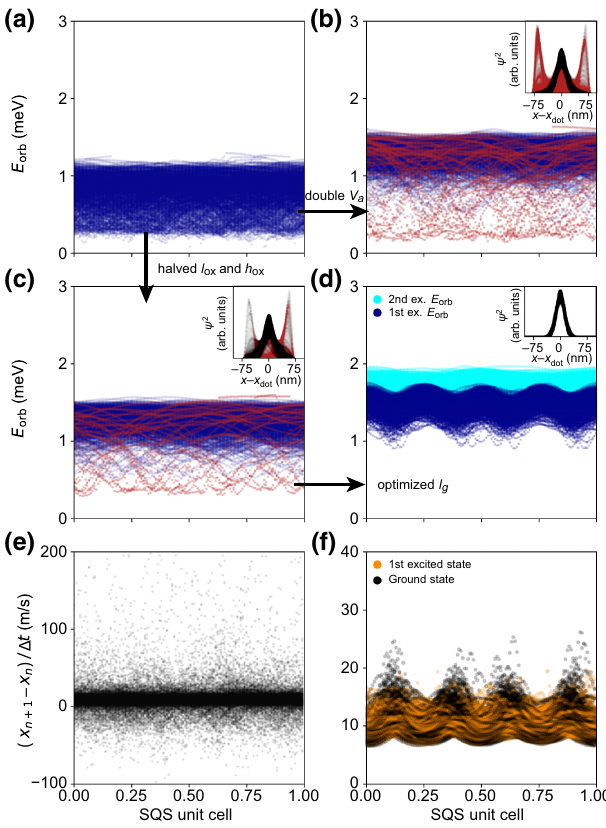
FIG. 7. Simulation based on Poisson-Schrödinger solutions of propagating potential in CB mode for 800 ensembles of ran- domly distributed charged defects at the Si/SiO 2 interface for h SiGe = 45 nm and w sp = 200 nm. (a) Orbital energy E orb of the first excited state of the propagating QD assuming an oxide thickness h ox = 10 nm, gate width l g = 30 nm and signal ampli- tude of V a ,1 = 45 mV and V a ,2 = 100 mV applied to the first and second claviature gate layer, respectively. (b) Same as in (a) with parameters ( h ox = 10 nm, V a ,1 = 90 mV, V a ,2 = 200 mV, (cid:2) | ψ( x , y ) | 2 dy of the l g = 30 nm). Inset: the probability density ground electron wave function is plotted for all expected QD positions x dot and all charge defect ensembles. Wave functions deviating from a single QD are marked in red together with their corresponding E orb data point. (c) Same as in (b) with param- eters ( h ox = 5 nm, V a ,1 = 60 mV, V a ,2 = 100 mV, l g = 30 nm) and the probability density in the inset. (d) Same as in (b) and (c) with parameters ( h ox = 5 nm, V a ,1 = 65 mV, V a ,2 = 100 mV, l g = 60 nm) and the probability density in the inset. In addition to the first excited orbital energy (blue dots), the second excited orbital energy is plotted (bright blue dots). (e),(f) The numeri- cally calculated velocity for each ensemble for the ground (black) and first excited state (orange) along the SQS direction is plotted corresponding to the parameters from (a) and (d),